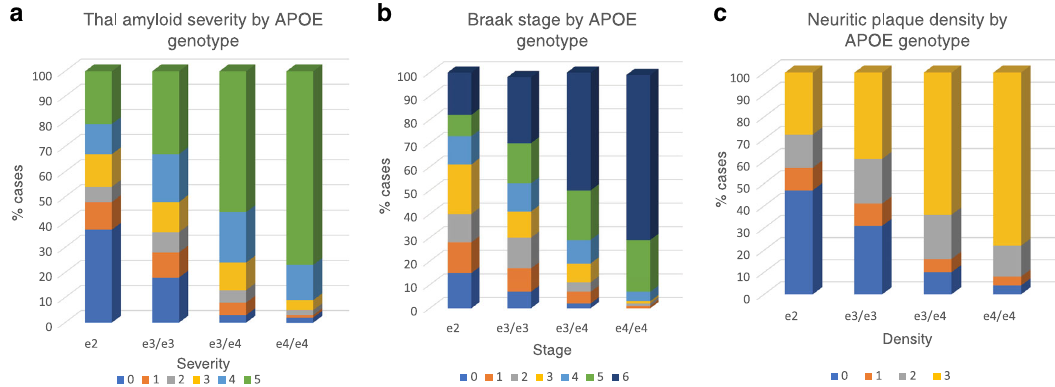
Fig. 1 Associations of APOE genotype with amyloid and tau neuropathologies. a Association of APOE genotype and diffuse amyloid plaque distribution. Within each APOE genotype column, colored rows represent the relative proportion of cases in each severity stage. These proportions are expressed as percentages and add to 100. There are increasing proportions of the most severe pathology (plaque stage 5) from the e2 to e4/e4 genotype groups in stepwise fashion. Amyloid stage 0 = no pathology; stage 5 = severe. b Association of APOE genotype and Braak stage. Within each APOE genotype column, colored rows represent the relative proportion of cases in each severity stage. These proportions are expressed as percentages and add to 100. There are increasing proportions of the most severe pathology (Braak stages v and vi) from the e2 to e4/e4 genotype groups in stepwise fashion. Braak stage 0 = no pathology; stage vi = severe neocortical pathology. c Association of APOE genotype and neuritic amyloid plaque density level. Within each APOE genotype column, colored rows represent the relative proportion of cases in each severity stage. These proportions are expressed as percentages and add to 100. There are increasing proportions of the most severe pathology (plaque stages v and vi) from the e2 to e4/e4 genotype groups in stepwise fashion. Neuritic plaque stage 0 = no pathology; stage 3 = severe